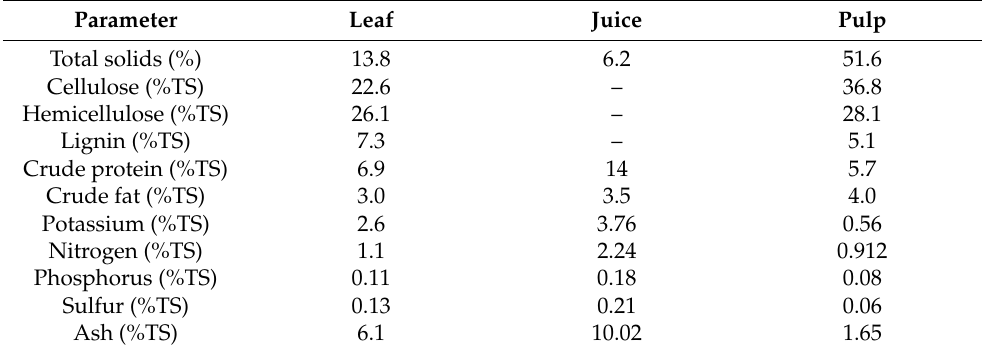
Table 1. Characteristics of pineapple leaves